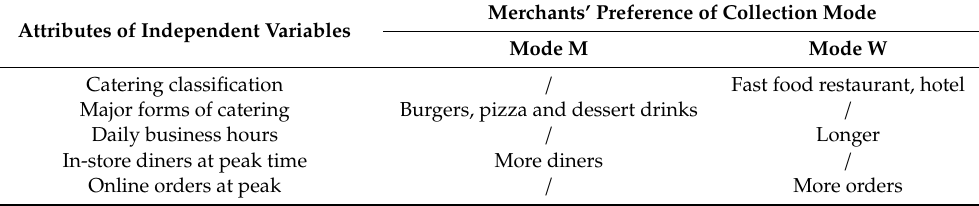
Table 8. Relationship between the attributes of the independent variables and the merchants’